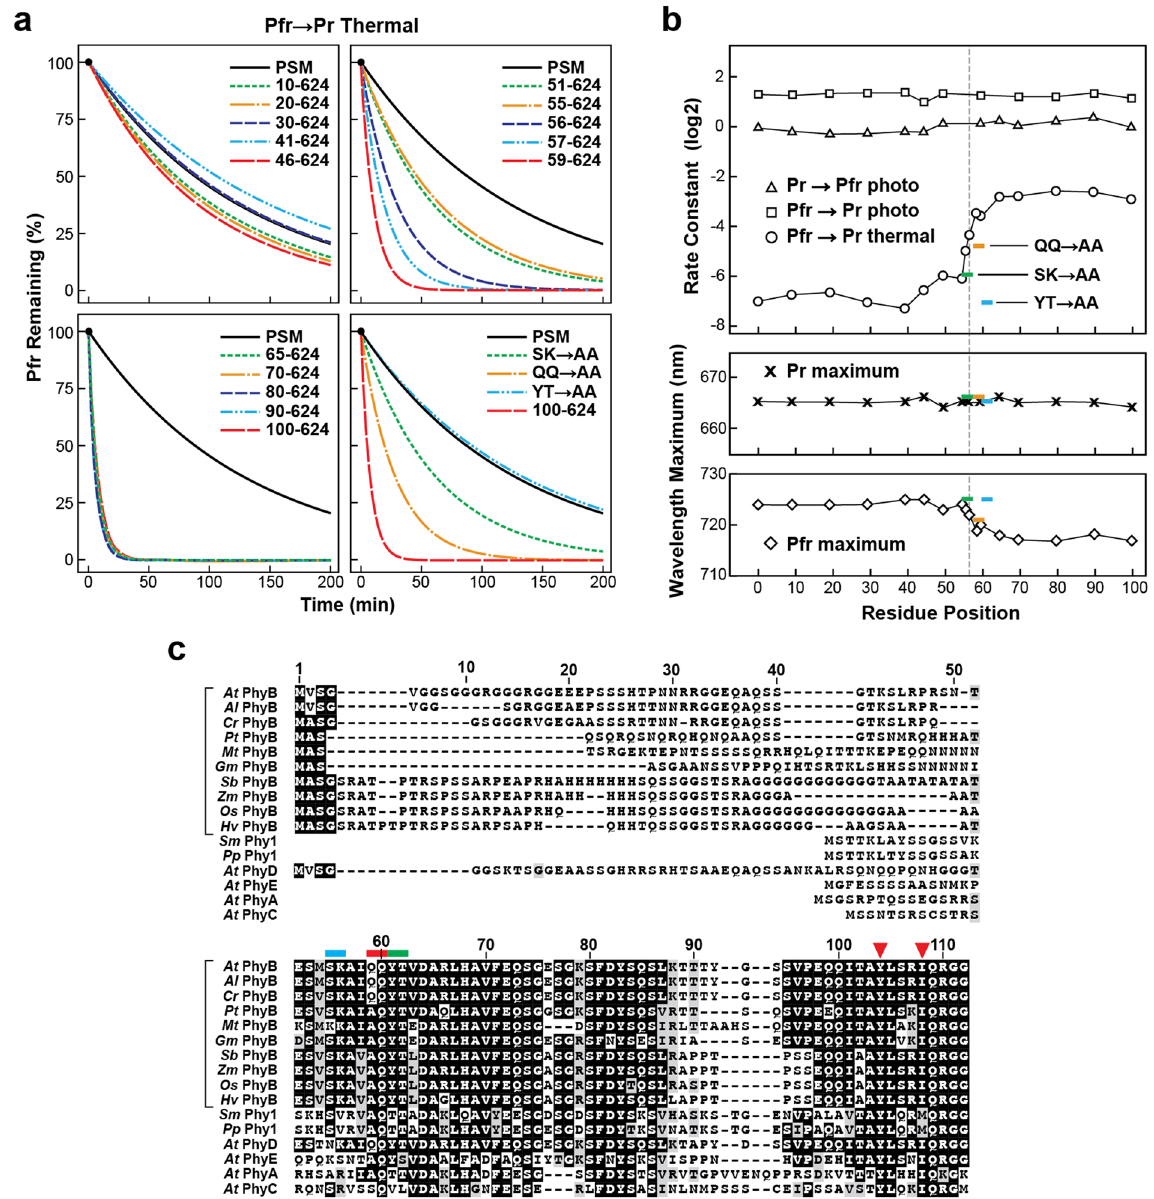
Figure 4. Region within the N-terminal extension (NTE) of PhyB influences the thermal reversion rate and absorption maximum of Pfr. Selected PSM fragments assembled with P Φ B are described in Fig. 3. ( a ) Pfr → Pr thermal reversion kinetics of both N-terminal truncations and site-directed mutants modifying the NTE. The SK → AA, QQ → AA and YT → AA alanine substitutions impacted residues Ser55-Lys56, Gln59-Gln60, and Tyr61-Thr62, respectively (see panel (c)). Kinetic traces were calculated from rate constants listed in Table 1. ( b ) Spectral properties of the PSM mutants described in panel (a). Rates of Pr → Pfr and Pfr → Pr photoconversion and thermal reversion (top). Absorption maxima of Pr (middle) and Pfr (bottom). (c) Alignment of representation PhyB sequences (brackets) within the plant kingdom and with the other four Phy isoforms (PhyA, C, D and E) in Arabidopsis. Identical and similar amino acids are shown in black and grey boxes, respectively. Dashes denote gaps. Amino acid residue numbers for Arabidopsis PhyB are shown above. Positions of the substitution mutations are shown by colored bars. Red arrows highlight residues in the crystallographic structure of the 90–624 fragment of Arabidopsis PhyB (PDB: 4OUR 21 ) that contact the bilin. Abbreviations: At , Arabidopsis thaliana ; Al , Arabidopsis lyrata ; Cr , Capsella rubella ; Pt , Populus trichocarpa ; Mt , Medicago truncatula ; Gm , Glycine max ; Sb , Sorghum bicolor ; Zm , Zea mays ; Os , Oryza sativa ; Hv , Hordeum vulgare ; Sm , Selaginella moellendorffii; and Pp , Physcomitrella patens